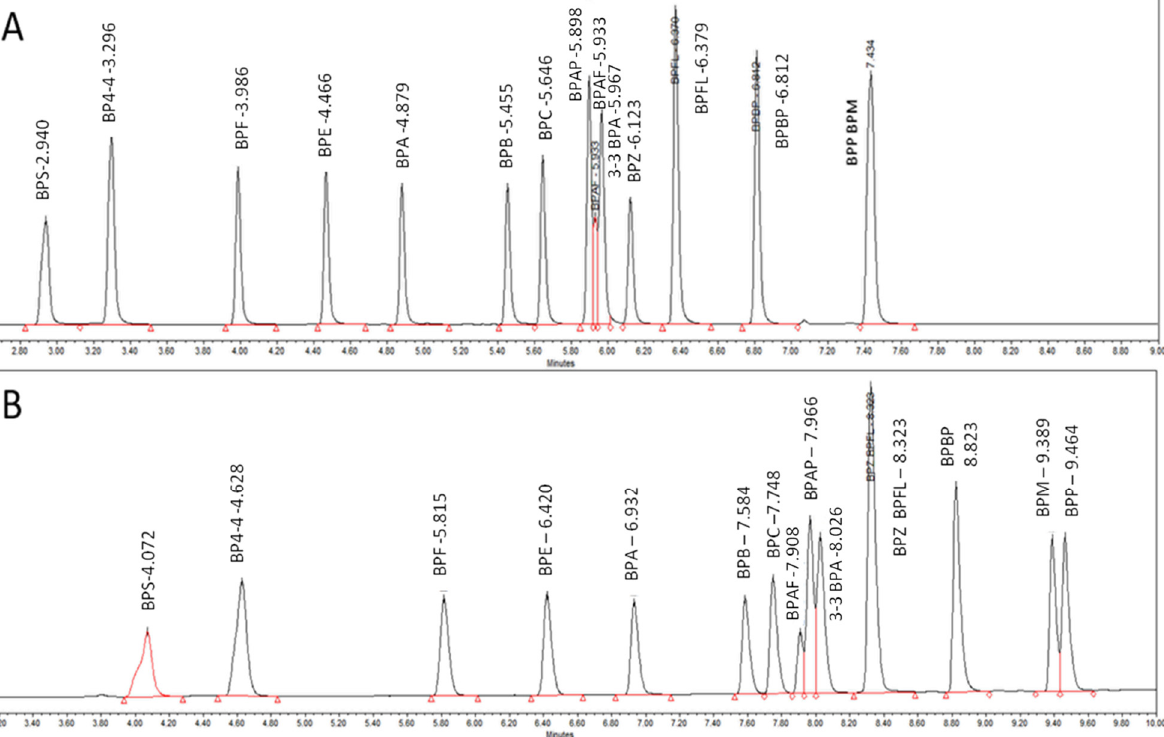
Figure 2. Chromatograms of 15 studied BPs eluted on a BEH C18 column with an AcN/H 2 O gradient elution ( A ) and with an MeOH/H 2 O gradient elution ( B ).